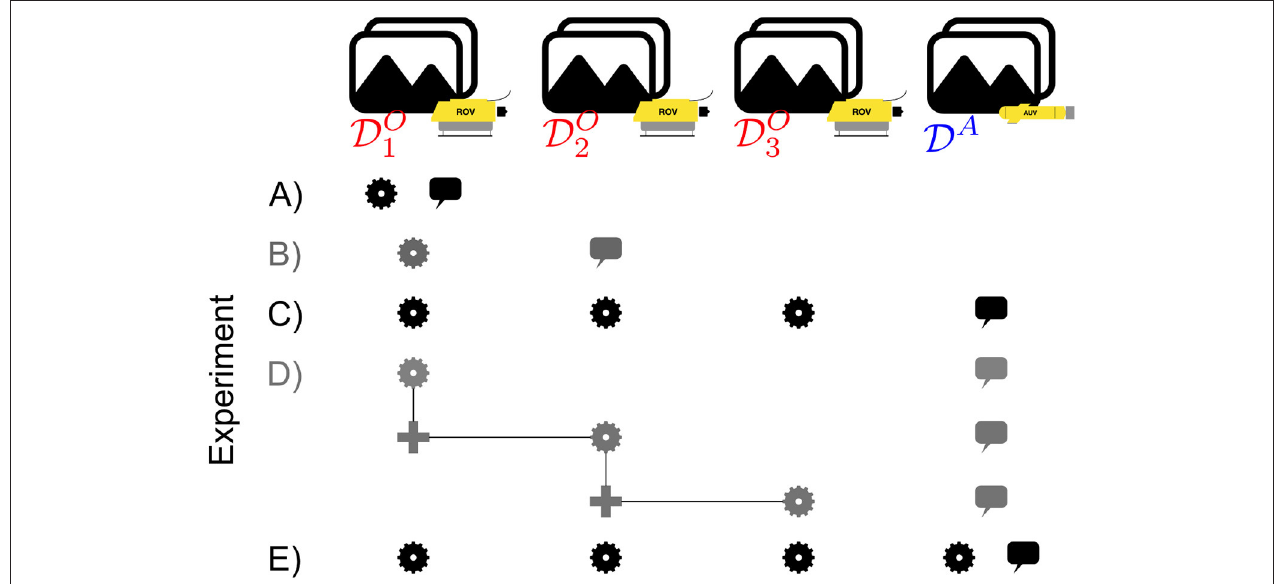
FIGURE 2 | Overview of study design. The cogs mark that this data set is part of the training data and the speech balloons mark the test set. The pluses symbolize the combination of single classifiers to one ensemble. There are multiple experiments for each setup, however, only one instance is shown as an example, i.e., for Experiment B D O 1 is used as training data and D O 2 as test data, however, the cases of e.g., D O 1 (training) and D O 3 (test) are